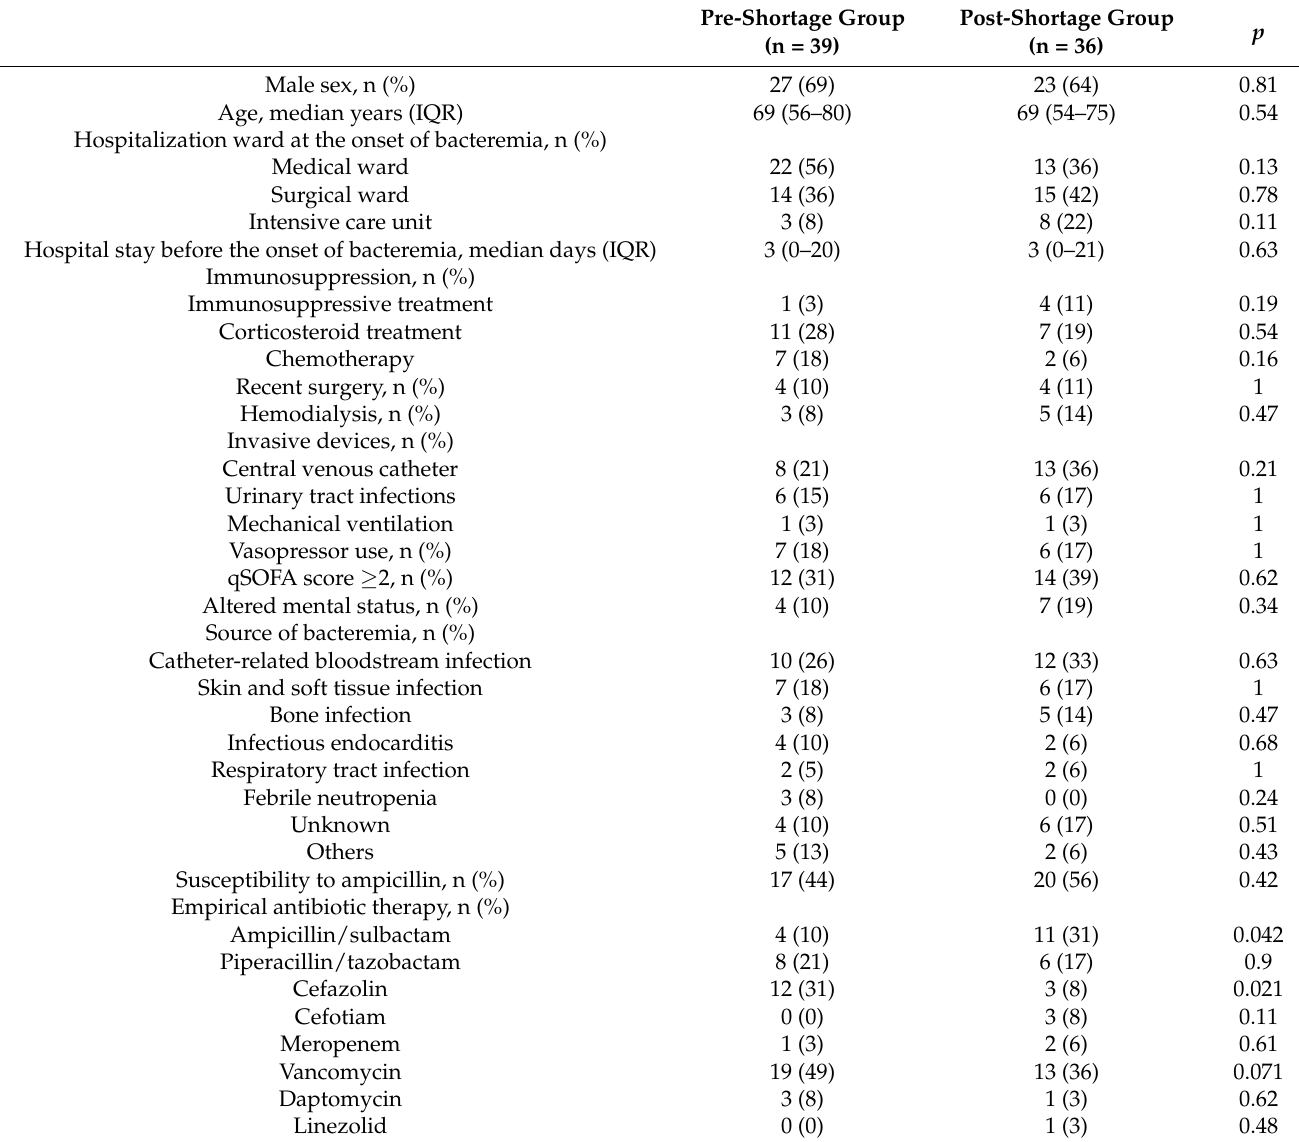
Table 1. Comparison of demographic characteristics of patients with MSSA